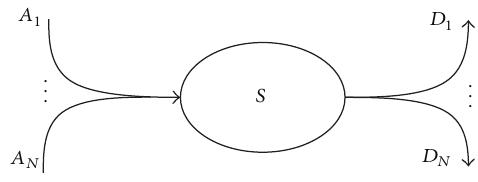
Table 2: Stochastic service curves. Type Form w.s.